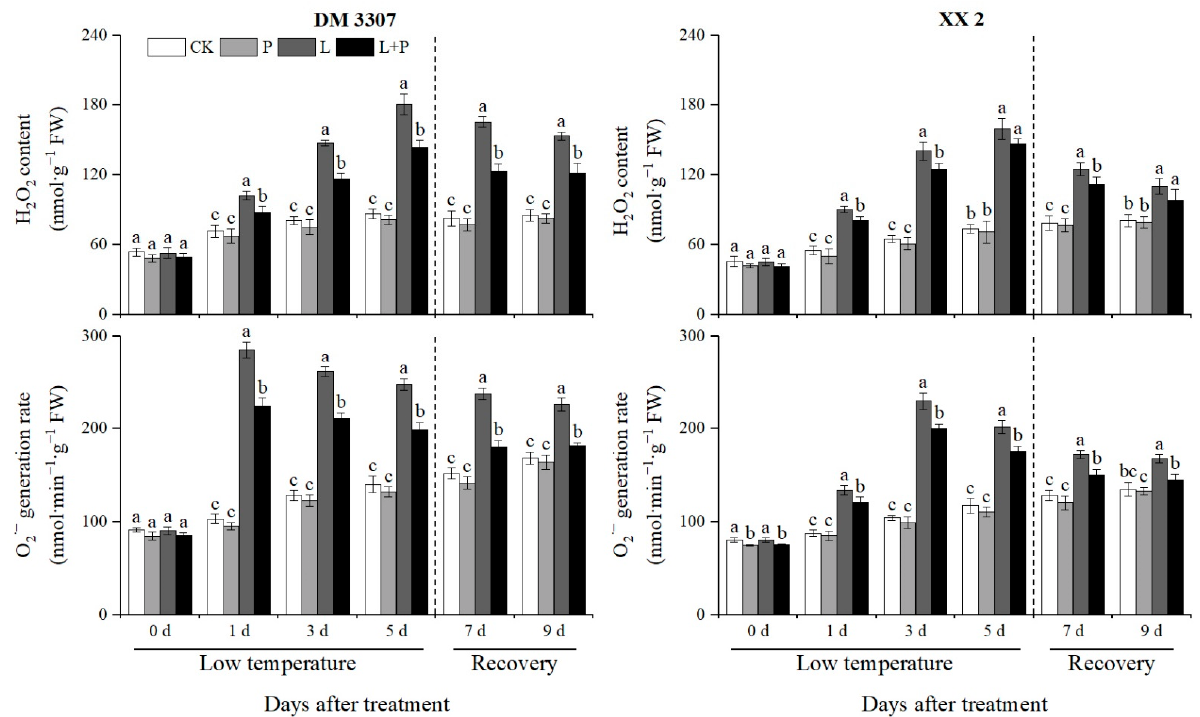
Figure 2. Effect of exogenous proline on H 2 O 2 content and O 2• − generation rate in embryos of maize under low − temperature stress. Notes: Data are expressed as mean ± standard deviation. Different letters within the same column indicate significant differences at the 5% level. CK: control group; P: proline treatment; L: low − temperature stress treatment; L + P: low − temperature stress + proline combined treatment. Different small letters represent significant differences between treatments ( p < 0.05).